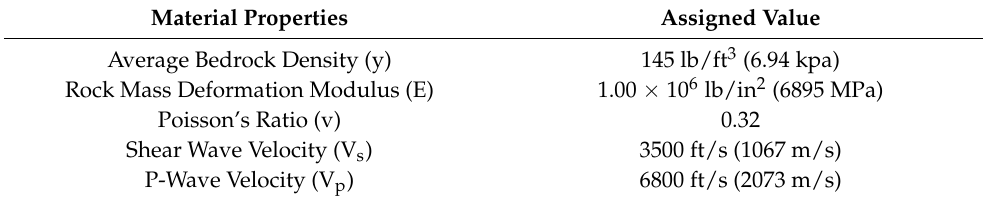
Table 2. Foundation material